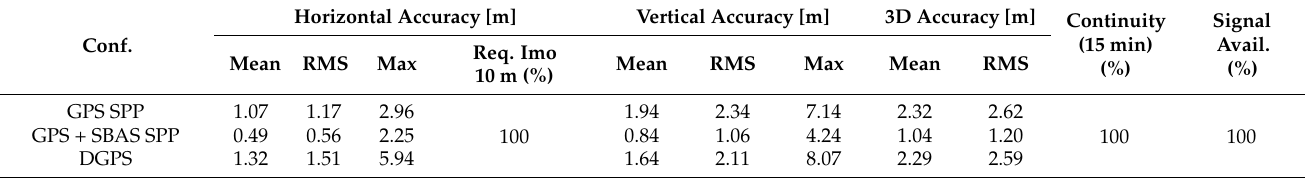
Table 2. Summary results of performance analysis conducted in terms of accuracy (using as figures of merit Root Mean Square (RMS), mean and maximum errors) for both horizontal (H) and vertical (Up) components of position, tridimensional accuracy (using as figures of merit Root Mean Square (RMS) and mean errors), IMO parameter on absolute horizontal accuracy, availability and continuity (over 15